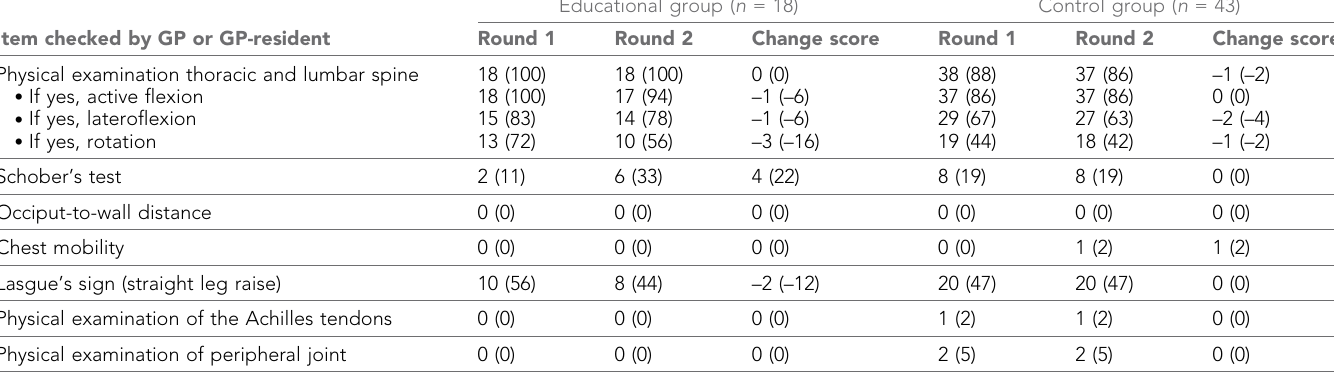
Table 4. Pattern of physical examination of GP(-residents) facing a patient with axial and peripheral SpA in round 1 and 2